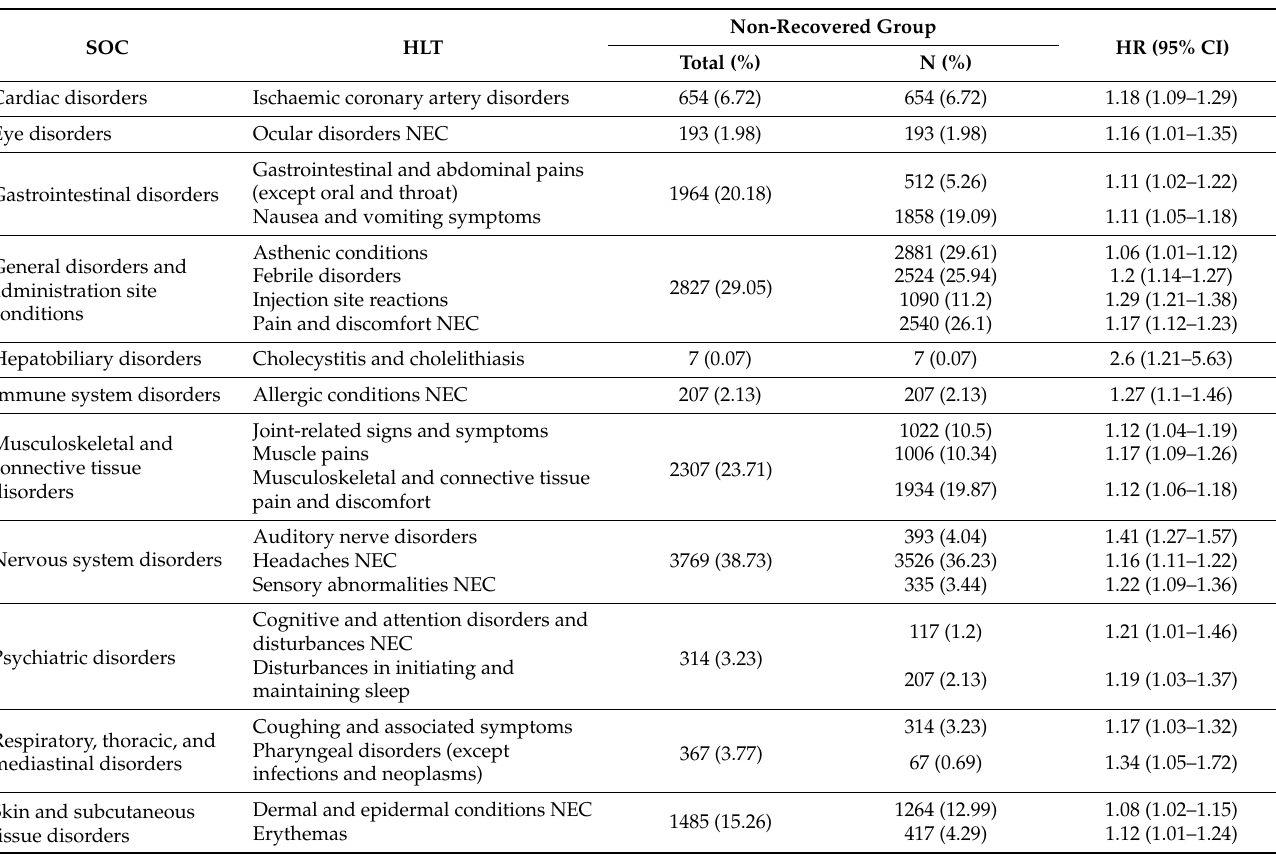
Table 2. AEFIs related to delayed recovery after receiving the Janssen COVID-19